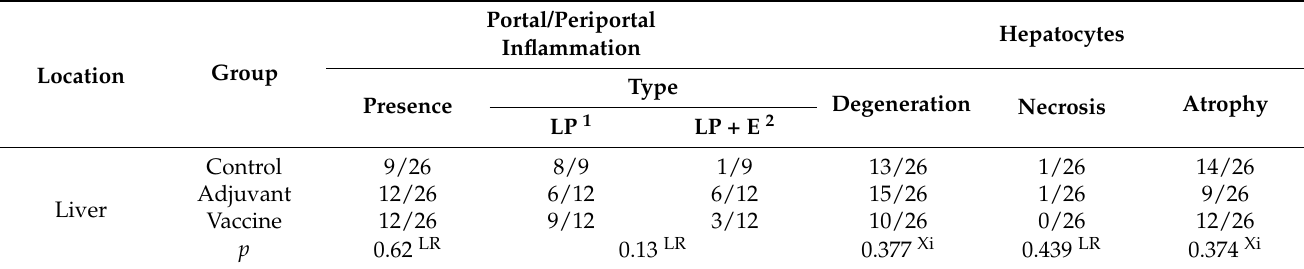
Table A16. Histopathological findings in the liver.